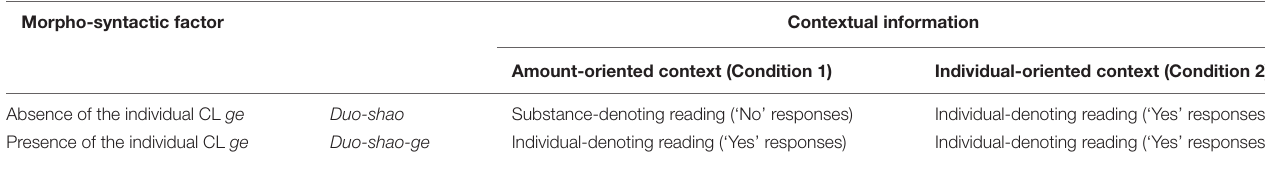
TABLE 1 | The experimental design of Experiment